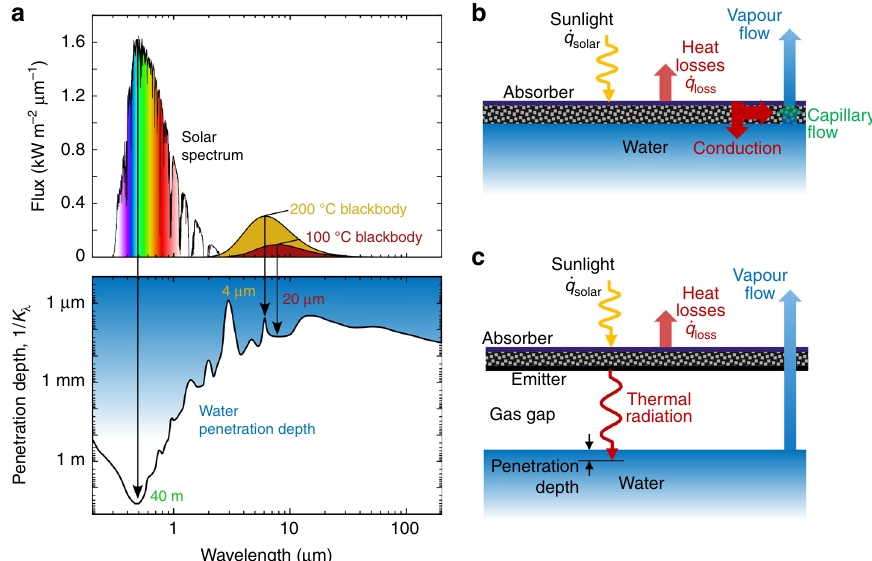
Fig. 1 Operating principle of contactless solar evaporation via thermal downconversion. a Bottom panel: photon penetration depth (reciprocal of absorption coef fi cient) for liquid water. Top panel: fl ux spectrum for solar radiation and for thermal blackbody sources at 100 and 200 °C. The penetration depth for solar photons is several orders of magnitude higher than that for thermal infrared photons. b In a conventional solar evaporation structure generator, a solar absorber is placed in contact with the water, and transfers heat from the absorbed sunlight to the water via thermal conduction. c In the proposed contactless solar evaporation structure, the absorber is not in contact with the water. As the absorber heats up, it emits thermal radiation to the water, which is absorbed within a very thin layer (<100 μ m) beneath the water/vapour